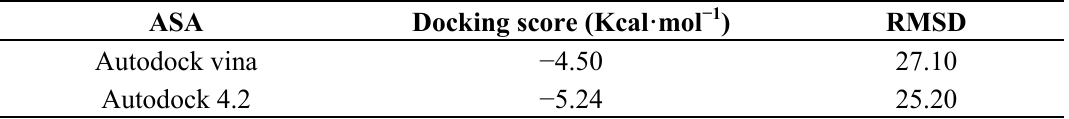
Table 2. The docking score between ASA and HSD with Autodock 4.2 and Autodock